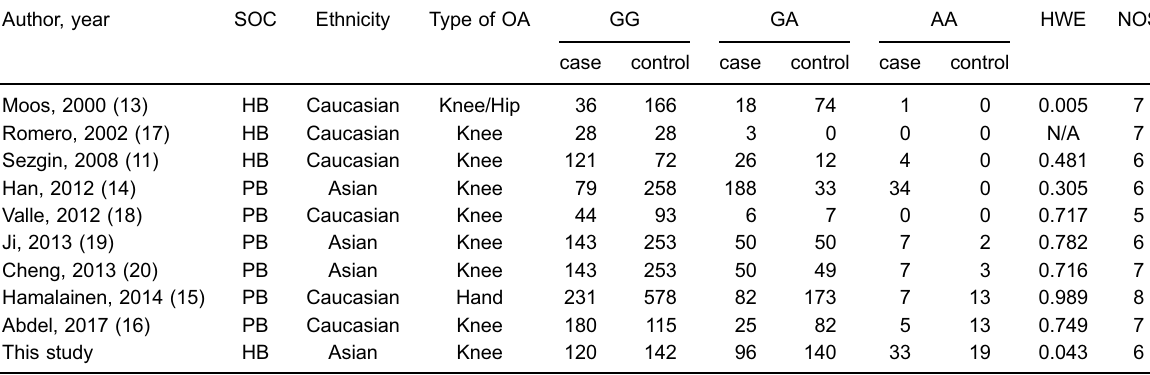
Table 3. Characteristics of included studies for different genotypes.